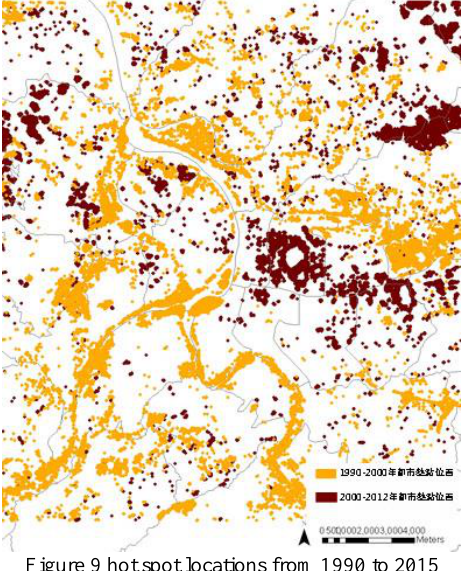
Figure 9 hot spot locations from 1990 to